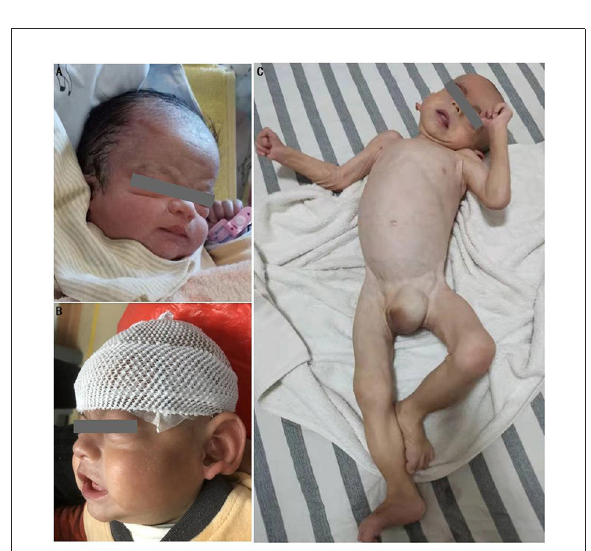
FIGURE2 Physical deformities of the patient. (A) characteristic midface retraction, frontal bossing, “wide-spaced” eyes, low nasal bridge, and low-set ears at 1 day after birth; (B) notable abnormalities in auricles at 6 months after birth; (C) joint contractures of extremities, trunk incurvation, left oblique inguinal hernia, and genital abnormalities at 18 months after